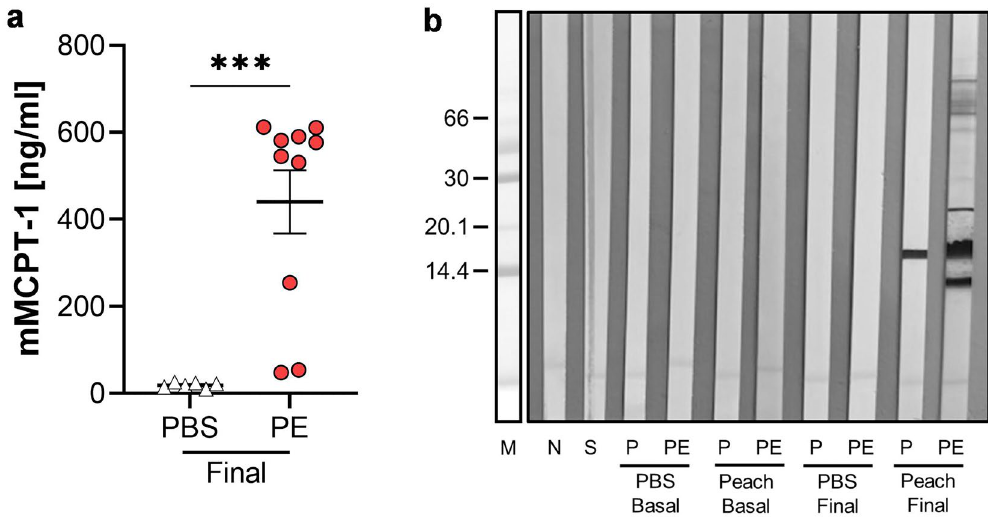
Figure 4. mMCPT-1 levels and IgG reactivity in serum. Levels of ( a ) mMCPT-1 were analyzed in the serum of the mice after (final) provocation via ELISA. ( b ) Peach extract (PE) and nPru p 3 (P) were subjected to SDS-PAGE followed by immunoblot analysis using serum pools from the experimental groups before (basal) or after provocation (final). n = 6–10, data presented as combination of 2 experiments performed under identical settings; *** p <